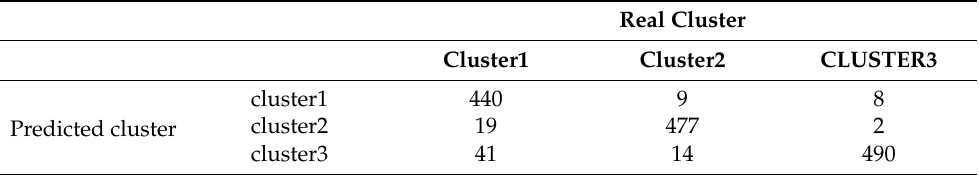
Table 1. Confusion Matrix of the simulation data based on the FCR-HL model.